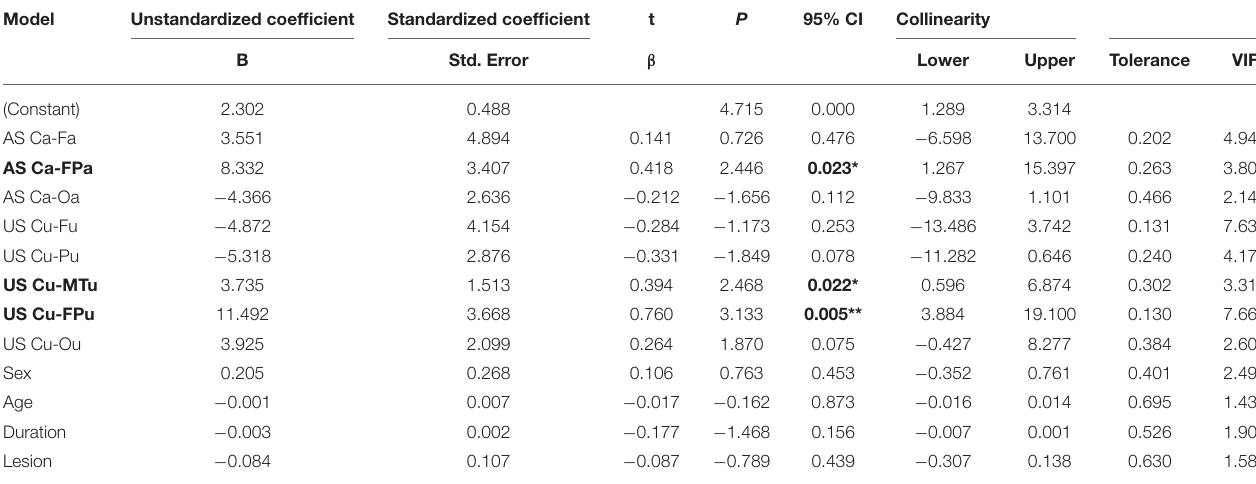
TABLE 4 | Regression analysis of C-ApEn in UWS.